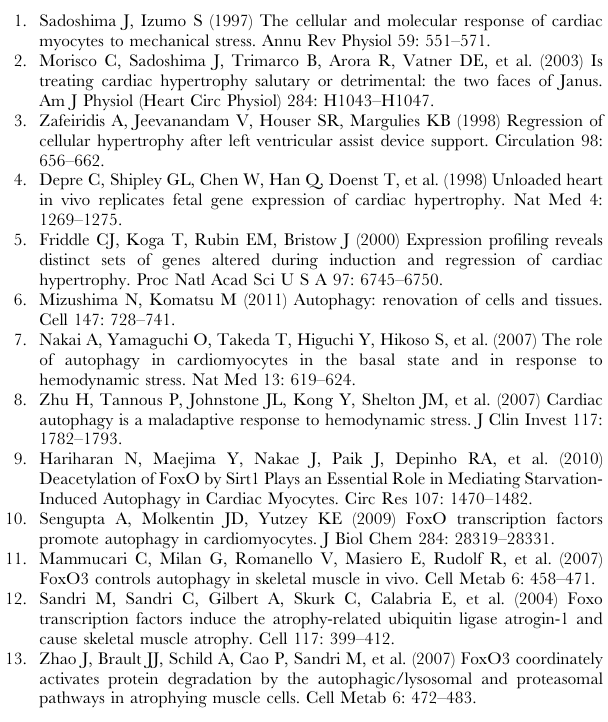
showing FoxO1, LC3 and tubulin in the heart. The level of a - tubulin is shown as a loading control. B. Densitometric analyses for LC3-II expression. The data are mean of two experiments. (TIF) Figure S4 Regression of cardiac hypertrophy was blunted in beclin1 + / 2 mice. Control C57BL/6 mice and transgenic mice with heterozygous knockout of Beclin1 ( beclin1 + / 2 ) were subjected to 1W TAC and 1W DeTAC surgeries. Percentage decrease in LVW/BW values after 1W TAC and 1W DeTAC compared to after 1W TAC alone is represented as % regression of cardiac hypertrophy in vivo . **p , 0.01. Table S1 Echocardiographic analyses of mice after TAC and